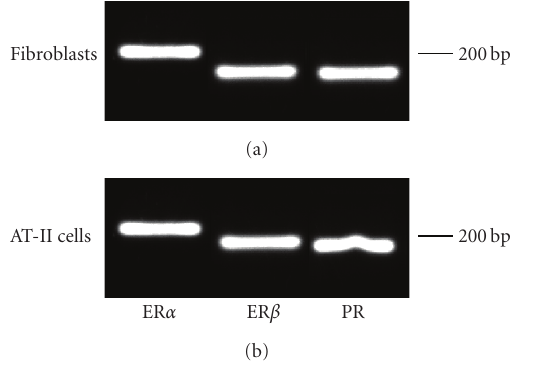
Figure 4: Quantitative analysis of VEGF gene expression in central lung fibroblasts treated for 48 hours with increasing concentrations of both E2 and P and with ICI/RU 486. Values were normalized against a housekeeping gene (HPRT) and expressed as % of controls. Note that the application of receptor antagonists 1 hour prior to hormone application (ICI/RU 486) antagonizes hormonal e ff ects. P < . 01 control versus E2/P-8M; ∗∗ P < . 01 control versus E/P-6M.